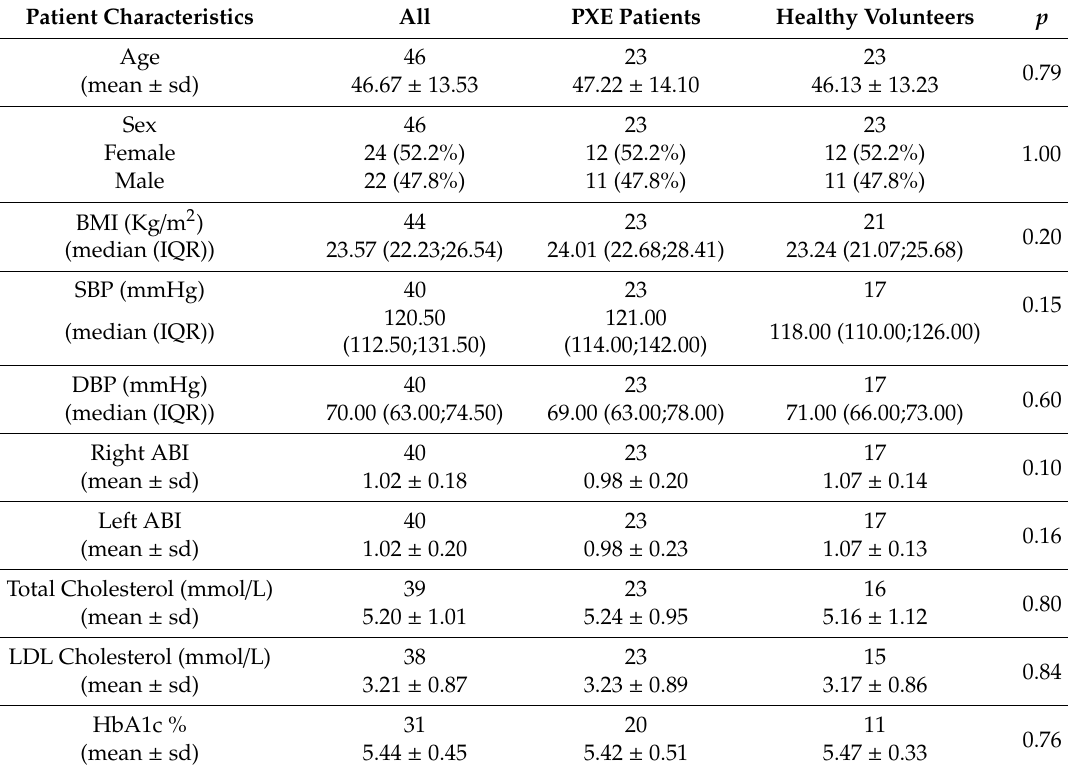
Table 1. Baseline Population